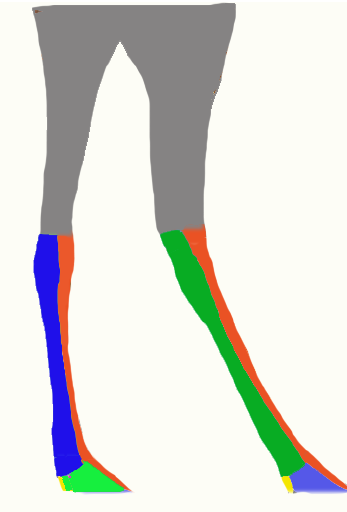
Figure 8. Cutaneous nerves of the medial and lateral surface of the metatarsus region in camels.